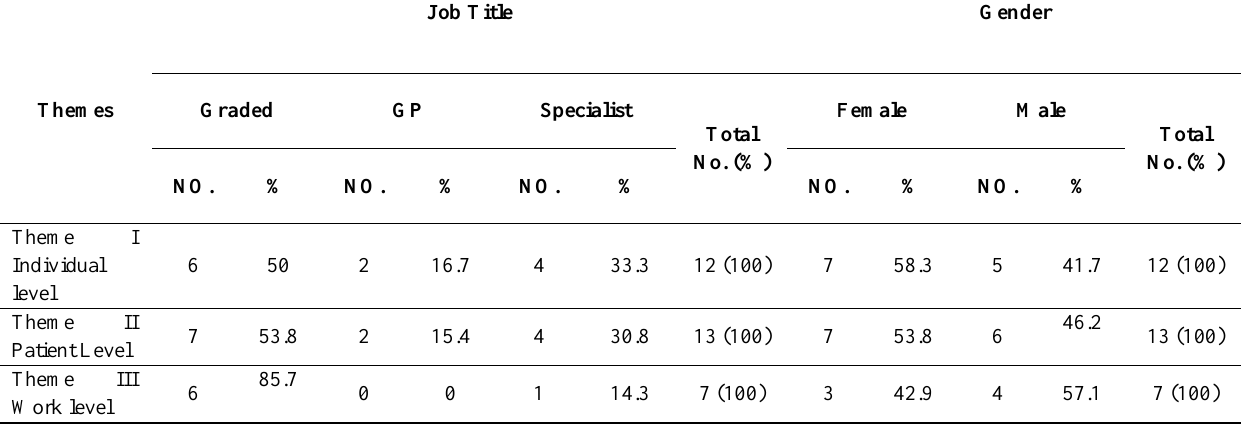
Table 6: Highest frequent responses percentages to questions according to highest ranking demographic features with burnout syndrome and its dimensions on individual, patient, and work level